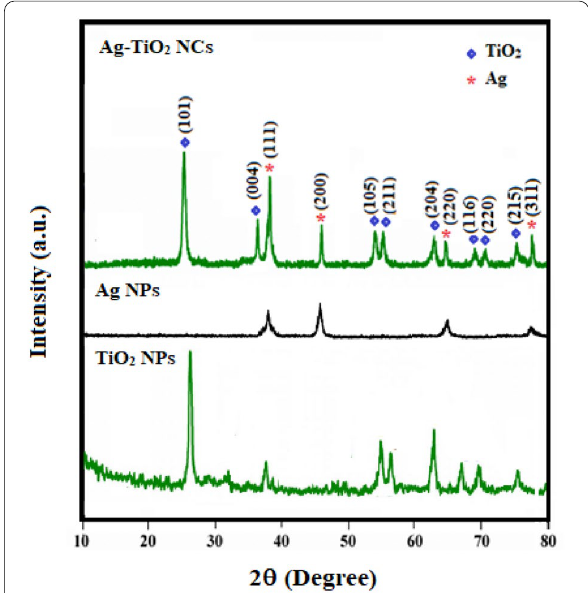
Fig. 3 XRD patterns of Ag–TiO 2 NCs, TiO 2 NPs and Ag